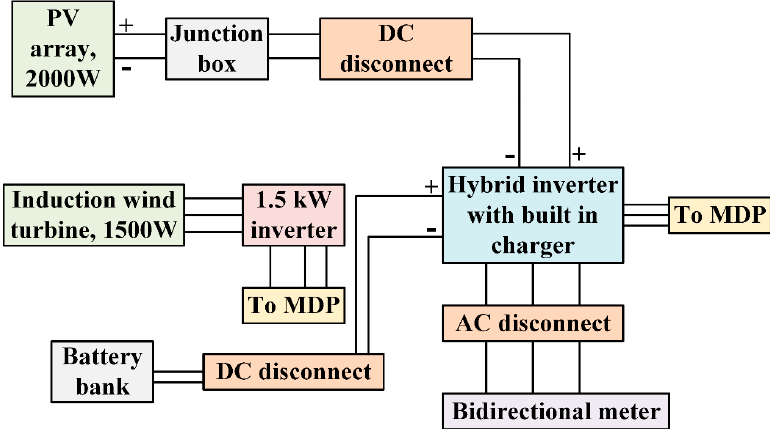
Figure 13. Layout of the SQU smart system consisting of PV Array, Wind Turbines, Battery banks, data network and bi-directional meter grid. This SG system is expected to contribute to the 50% reduction of diesel consumption of Oman [102,113].